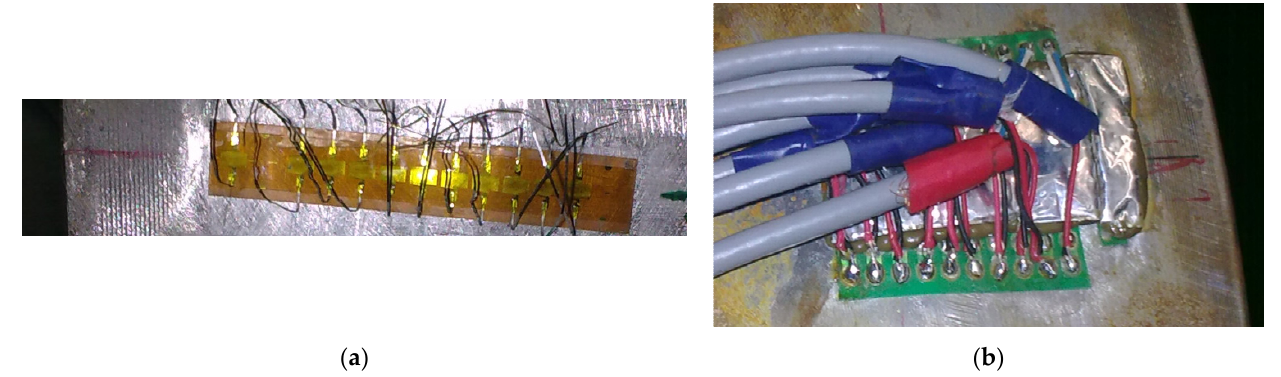
Figure 6. Photographs of strain gauges chain glued on tested pressure vessel: ( a ) strain gauge before connecting the wires; ( b ) finished connection.